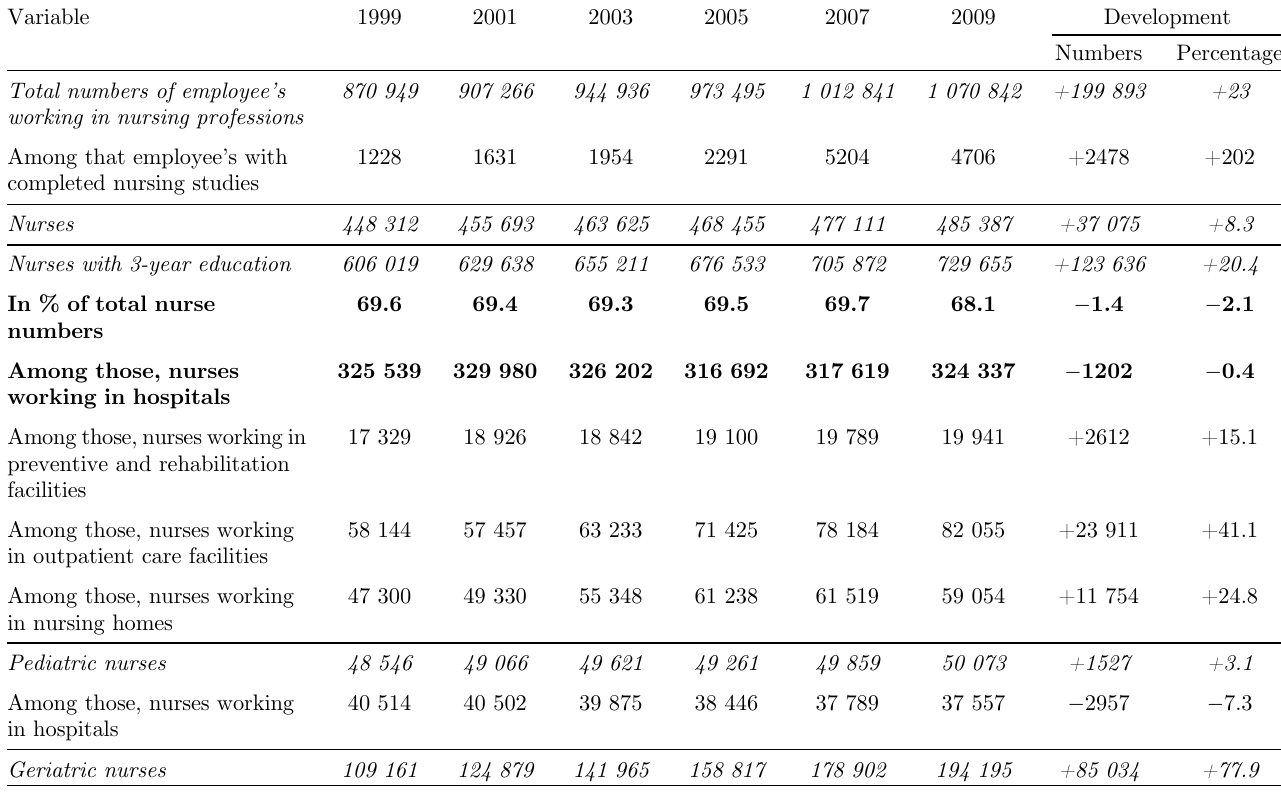
Table 3. Numbers of nurses in Germany.